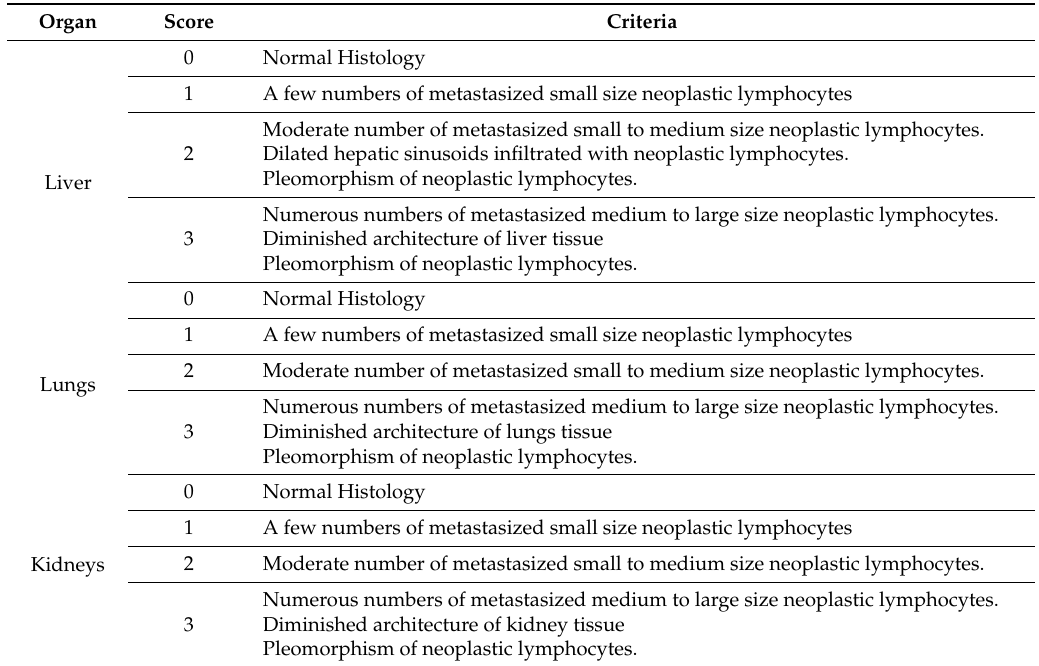
Table 8. Histopathological lesion scoring in the liver, kidneys, and lungs of leukaemia-bearing